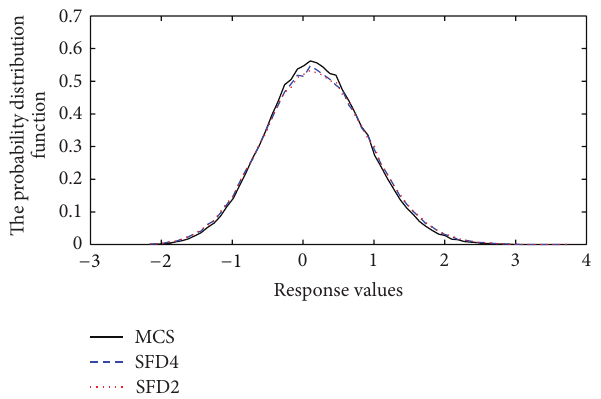
Figure 9: The pdf at point 𝐶 using SFD4 and SFD2.